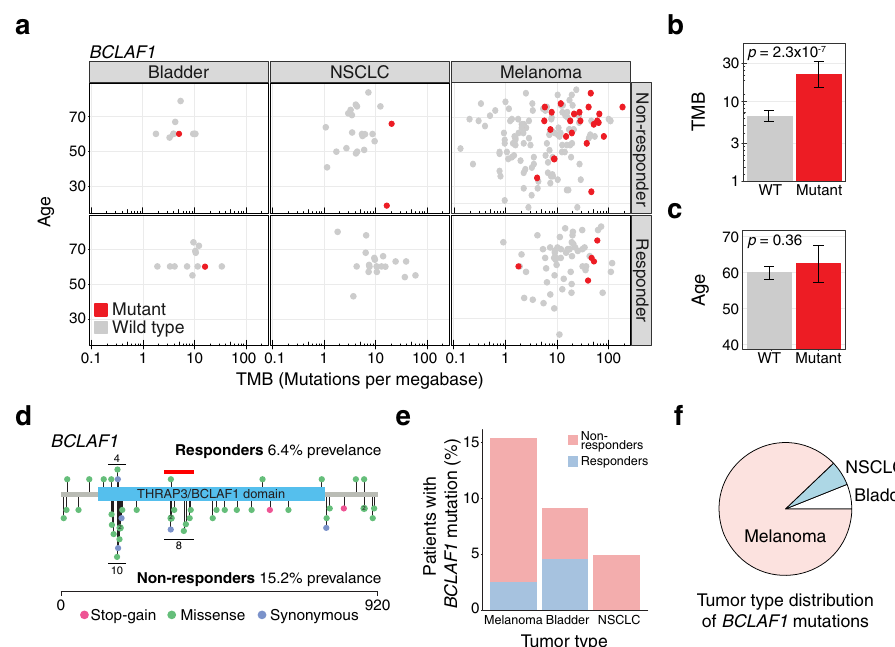
Fig. 3 BCLAF1 mutations identify a subset of non-responders with high tumor mutational burden (TMB). a Age, TMB and tumor type for responders and non-responders with ( red ) and without ( gray ) BCLAF1 mutations. b TMB of patients with ( n = 33) and without ( n = 239) mutations in BCLAF1 . Signi fi cance was calculated using a two-sided Welch ’ s t test and error bars indicate 95% con fi dence intervals. c Age of patients with ( n = 33) and without ( n = 239) mutations in BCLAF1 . Signi fi cance was calculated using a two-sided Welch ’ s t test and error bars indicate 95% con fi dence intervals. d Protein location of mutations in BCLAF1 in responders ( top ) and non-responders ( bottom ). Mutations are color-coded by mutation type. Horizontal black lines indicate mutational clusters. The red horizontal line indicates a mutational cluster not present in responders. e Prevalence of BCLAF1 mutations in melanoma, bladder, and NSCLC cancer by ICB response status. f Distribution of BCLAF1 mutations by tumor